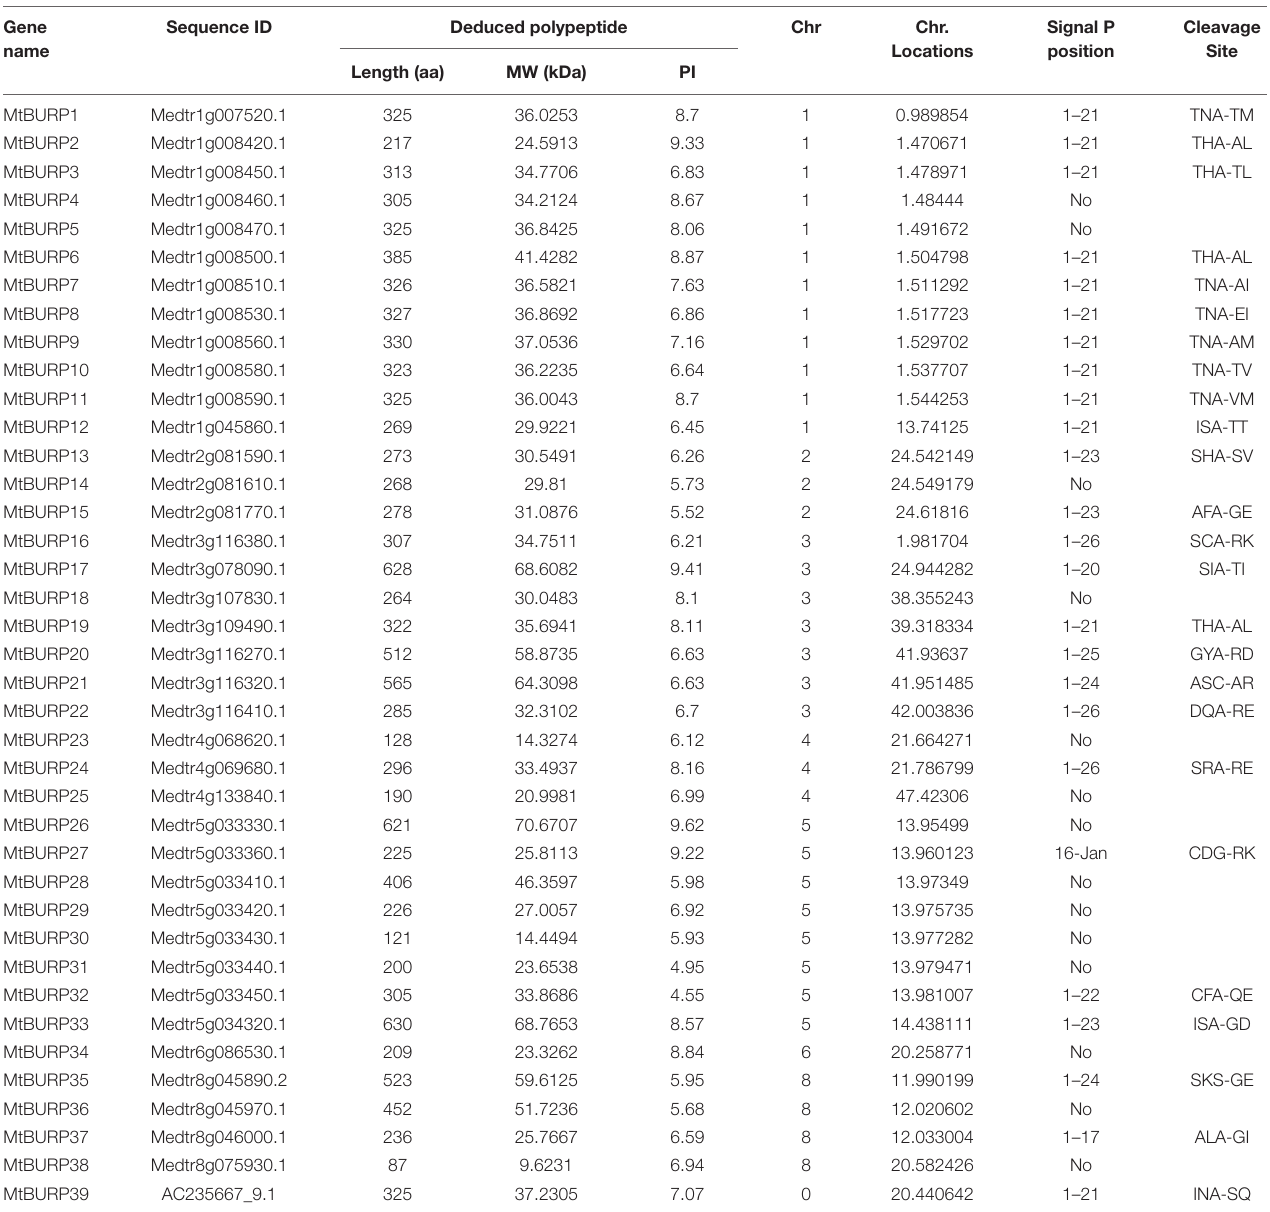
TABLE 1 | Sequence characteristics of 39 BURP genes identified in Medicago truncatula